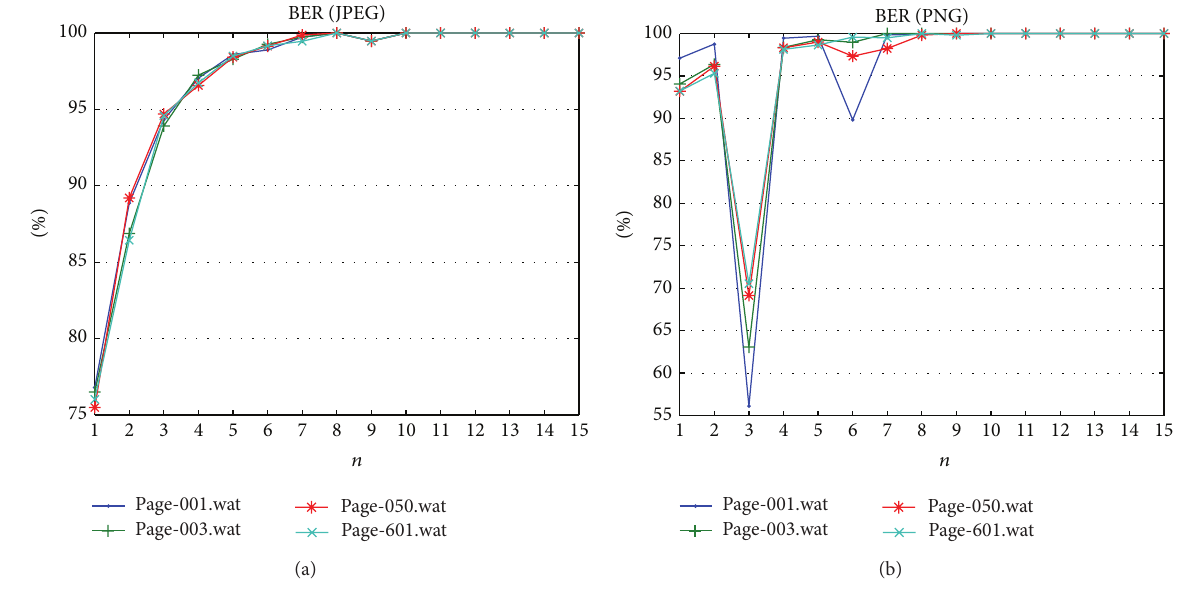
Figure 9: Bit error rates result against Gaussian blurring attack. Table 15: Bit error rates result on median filtering